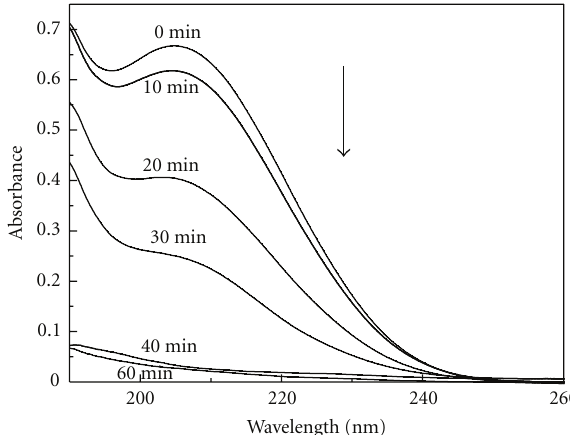
Figure 8: Change of UV spectra of formic acid at various reaction intervals for PEC process in the presence of 0.8V versus SCE anodic